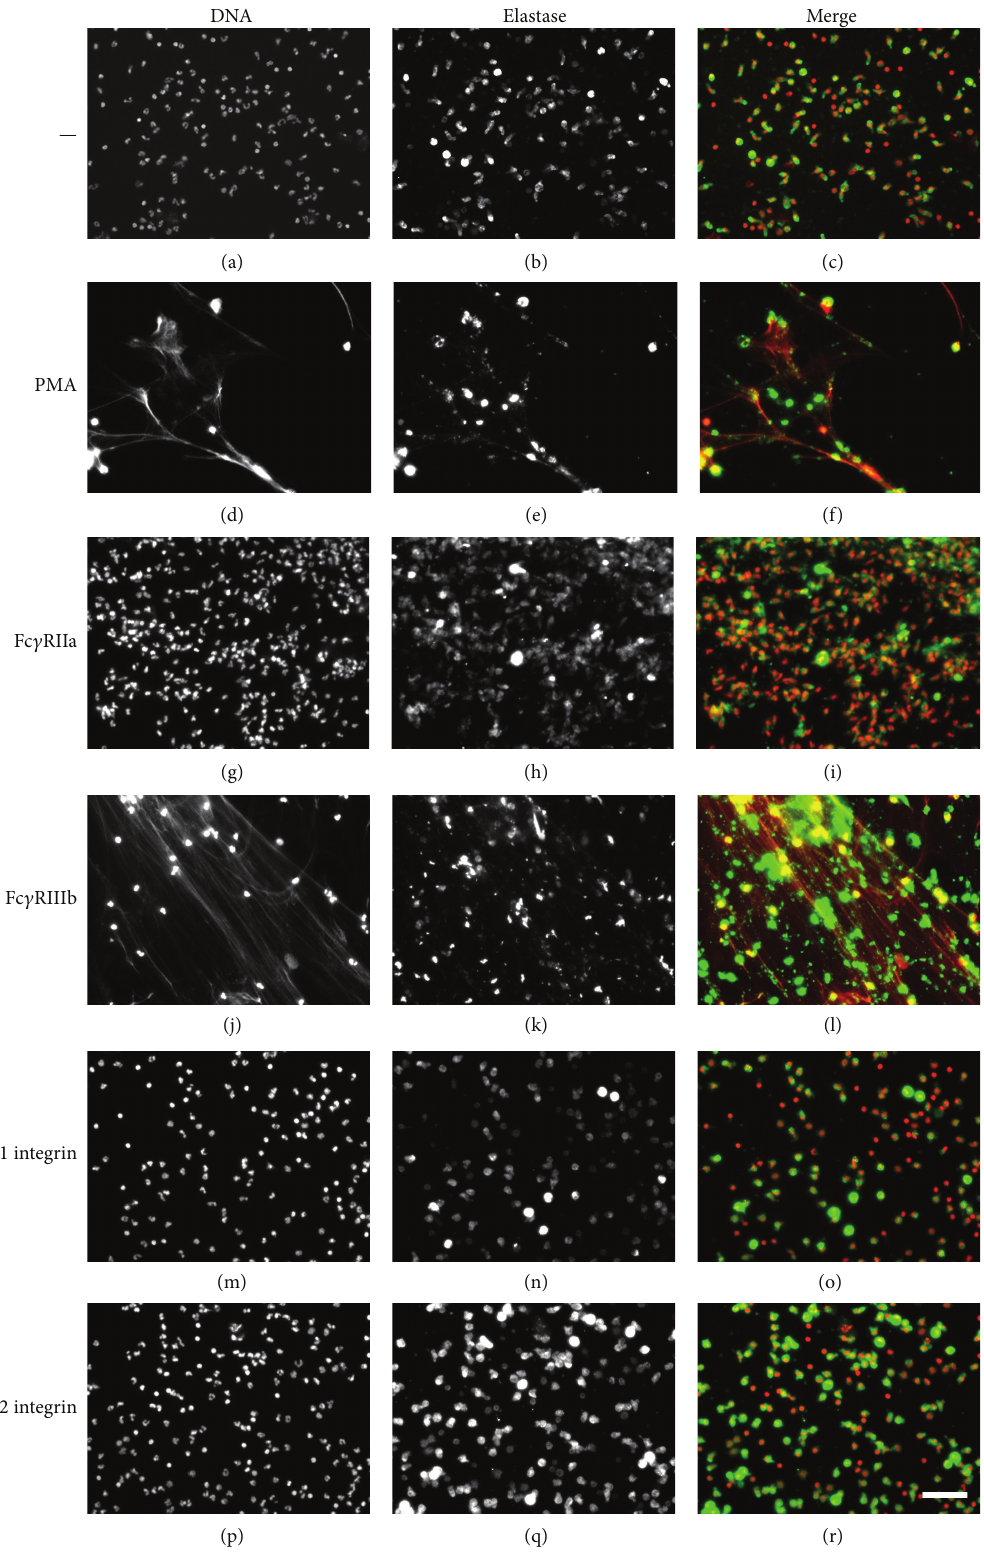
Figure 3: NETs are decorated with neutrophil elastase. Human neutrophils (PMN) were stimulated with 20 nM phorbol 12-myristate 13- acetate (PMA), by cross-linking Fc 𝛾 RIIa with mAb IV.3, by cross-linking Fc 𝛾 RIIIb with mAb 3G8, by cross-linking 𝛽 1 integrins with mAb TS2/16, or by cross-linking 𝛽 1 integrins with mAb IB4. After four hours, PMN were fixed and stained for DNA (DAPI, red) or for elastase (green). Microphotographs were taken at 200x magnification and are representative of five experiments. Bar is 50 𝜇